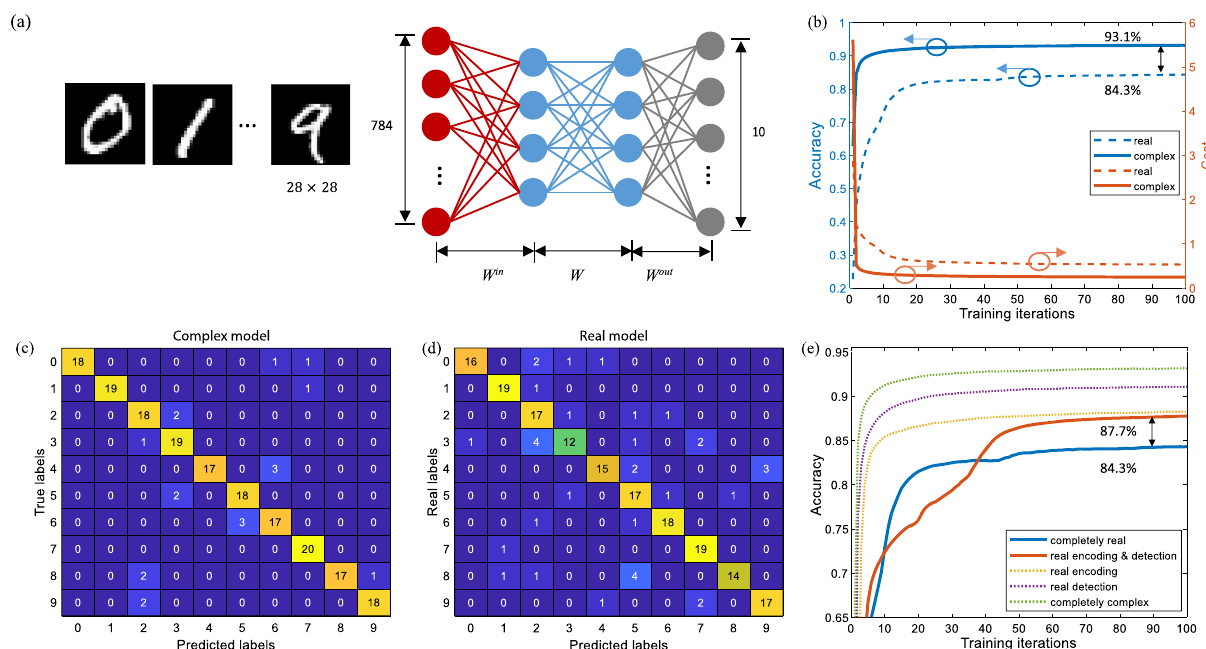
Fig. 6 Handwriting recognition with a complex-valued multilayer perceptron. a The network consists of an input layer W in , a hidden layer W and an output layer W out . All 10 digits are included in our experiment. The input image sized as 28 × 28 is stretched into a 784× 1 vector. The output layer maps the four hidden outputs to 10 classes. b The performance comparison of complex-valued and real-valued network implemented on the same chip. The blue and orange curves represent the accuracy and the cost of training, respectively. The solid line represents the complex-valued algorithm while the dashed line represents the real-valued algorithm. The training accuracy of complex-valued and real-valued models are 93.1% and 84.3%, respectively. In addition, a faster convergence is observed in complex model. c The confusion matrix by the chip-implemented complex model, when evaluating on testing set. Each column of the matrix represents the instances in a predicted label while each row represents the instances in a true label. The diagonal elements represent the number of instances that are correctly predicted. The chip testing accuracy is 90.5%. d The confusion matrix by the real model, showing a testing accuracy of 82.0%. e Sceneries are investigated, where complex-valued weights are implemented on chip, but input encoding and output detection are either complex-valued or real-valued. Their training curves are shown. Notably, even when we restrict both the encoding and detection to be real-valued, the complex-valued model exhibits a superior performance (87.7%) over its real-valued counterpart (84.3%).